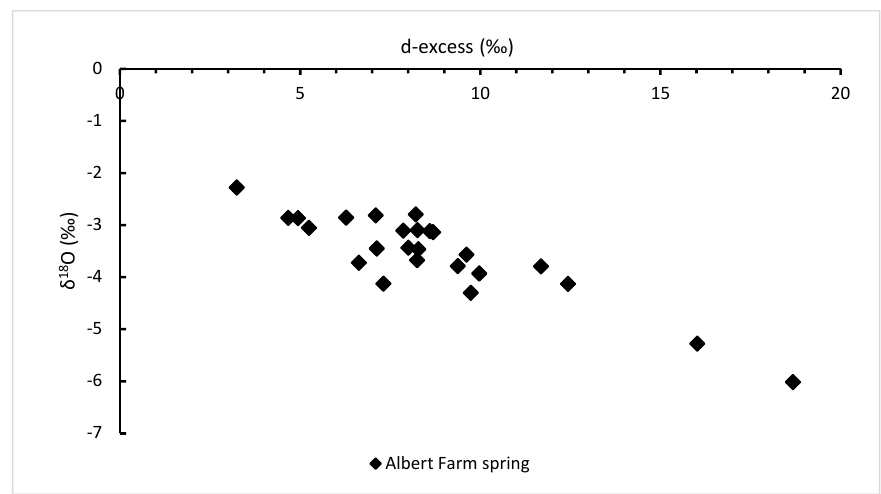
Figure 5. Plot of d-excess versus δ 18 O for the monthly Albert farm spring samples. A d-excess value in precipitation depends on the temperature and humidity condi- tions at the sea surface where evaporation took place and the humidity along the moisture trajectory [20,40,41]. A high variation that is observed in the plot of δ 18 O versus d-excess (Figure 5) indicates that the aquifer that feeds the Albert Farm spring is recharged by rain- fall events that were generated under different humidity conditions, or from different moisture sources, i.e., the local surface water bodies, warmer Indian Ocean, cooler Atlan- tic Ocean or the high-latitude cold Antarctica. In an investigation of stable isotope effects and moisture trajectories for rainfall in Johannesburg, Leketa and Abiye [33] reported high variability in stable isotopes of Johannesburg rainfall for the period between November 2016 and October 2018. Through the use of a Hybrid Single Particle Lagrangian Integrated Trajectory model (HYSPLIT; https://www.ready.noaa.gov/HYSPLIT.php), they further determined the dependence of Johannesburg rainfall isotopic signature on the trajectory and residence time of moisture over the Indian versus the Atlantic Ocean en route to Jo- hannesburg. The trajectory of rainfall with low d-excess displays an anticlockwise circu- lation with the longest residence time above the Indian Ocean where it experienced con- ditions that altered its isotopic signature. The moisture for rainfall with high d-excess had longer residence time above the higher latitudes south of the South African coastline, after which it experienced a semi-direct trajectory to Johannesburg. Therefore, the observed variability is likely a reflection of the moisture trajectories and residence times above the Indian Ocean.